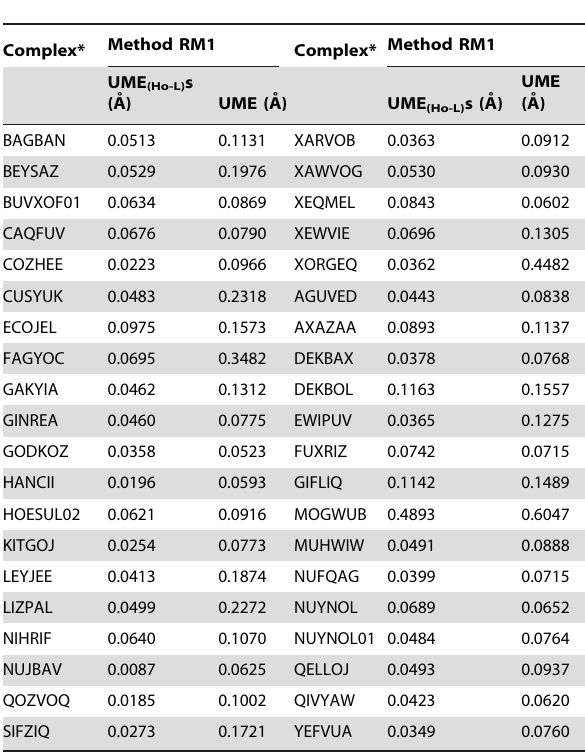
Table 3. Unsigned mean errors, UME (Ho-L) s and UMEs, for the RM1 model for the lanthanides, as compared to the respective experimental crystallographic values, obtained from the Cambridge Structural Database, [37–39] for each of the 40 holmium (III)